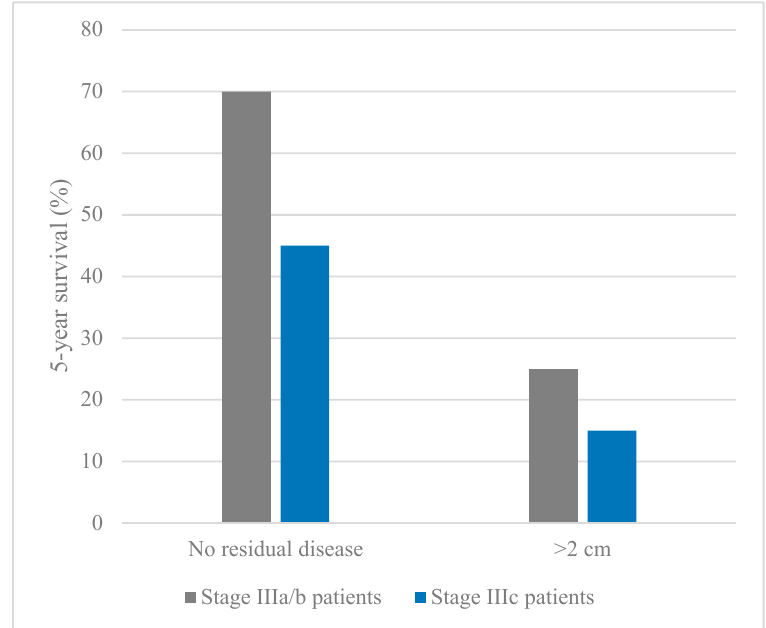
Figure 2. 5-year survival in stage IIIa/b and IIIc patients with optimal and suboptimal resection at primary cytoreductive surgery [26,174].